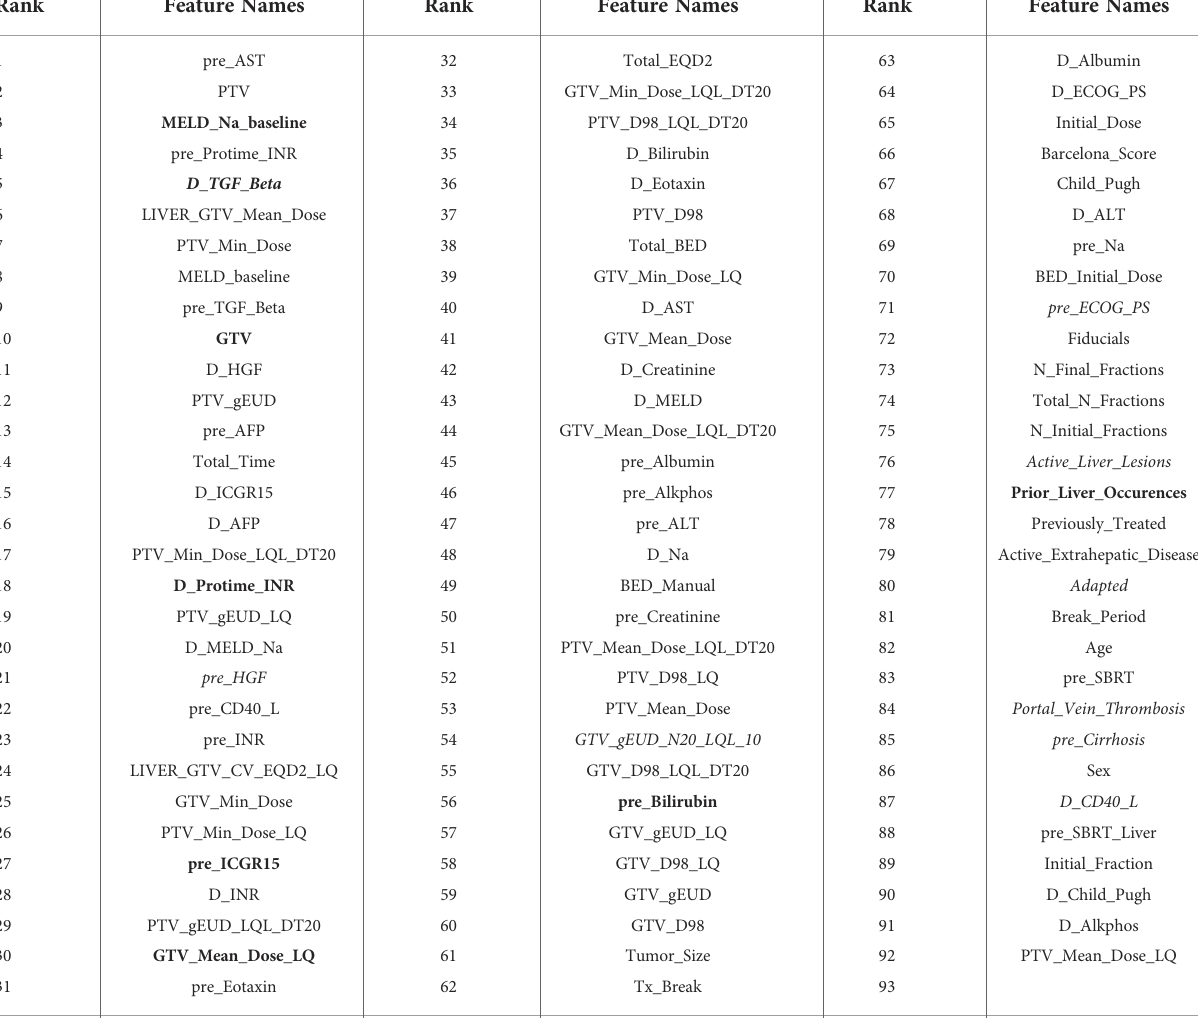
TABLE 6 The rank of features in an integrated feature ranking list for during-treatment LC prediction.